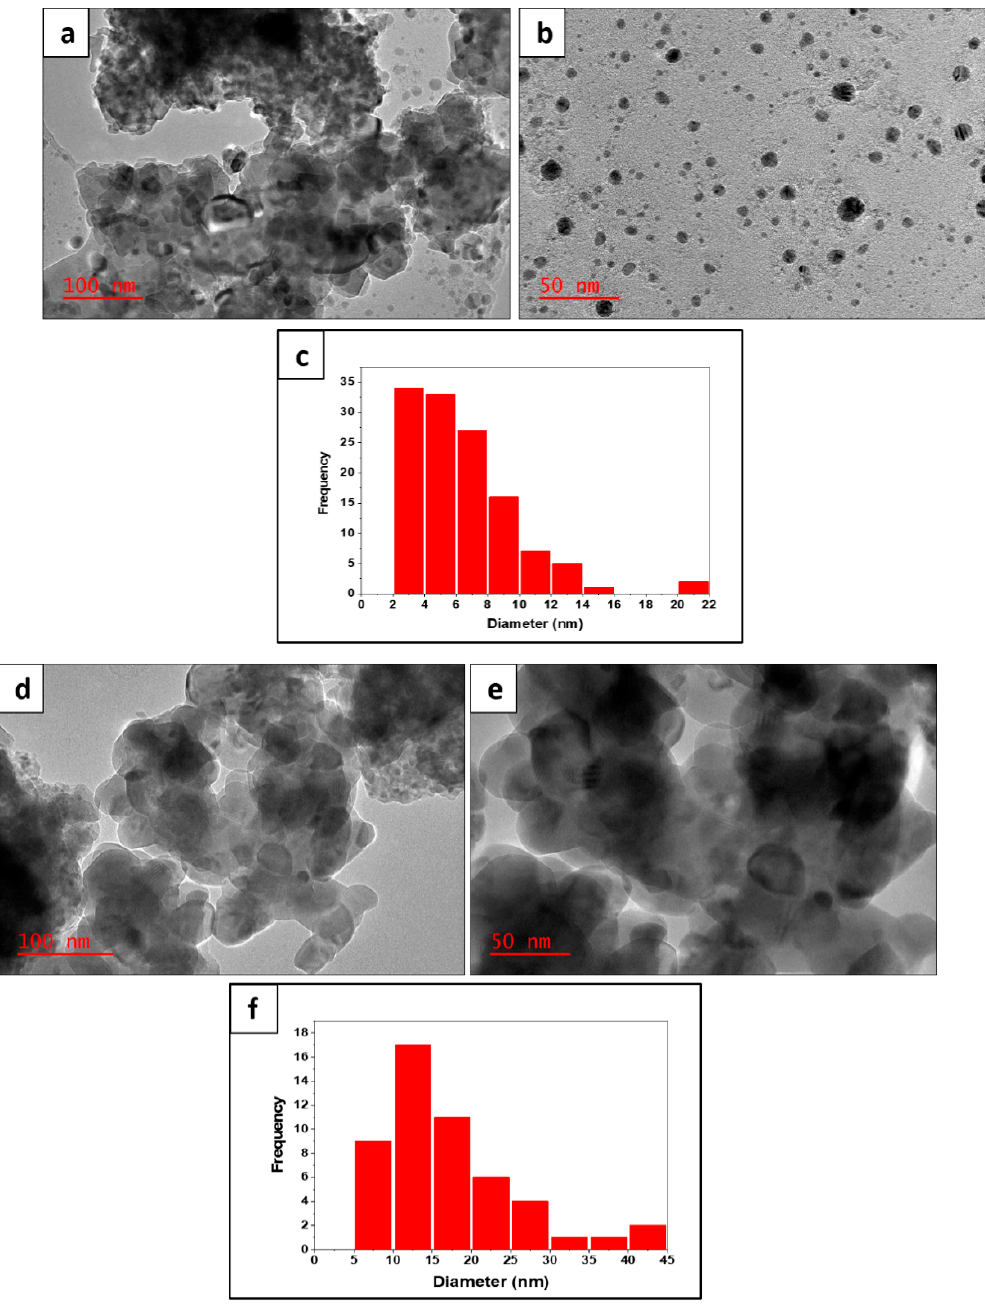
Figure 2. TEM images and particle size distribution histograms of NiMo/CaTiO 3 catalysts containing different CaTiO 3 content: ( a – c ) NMC412 and ( d – f ) NMC414.